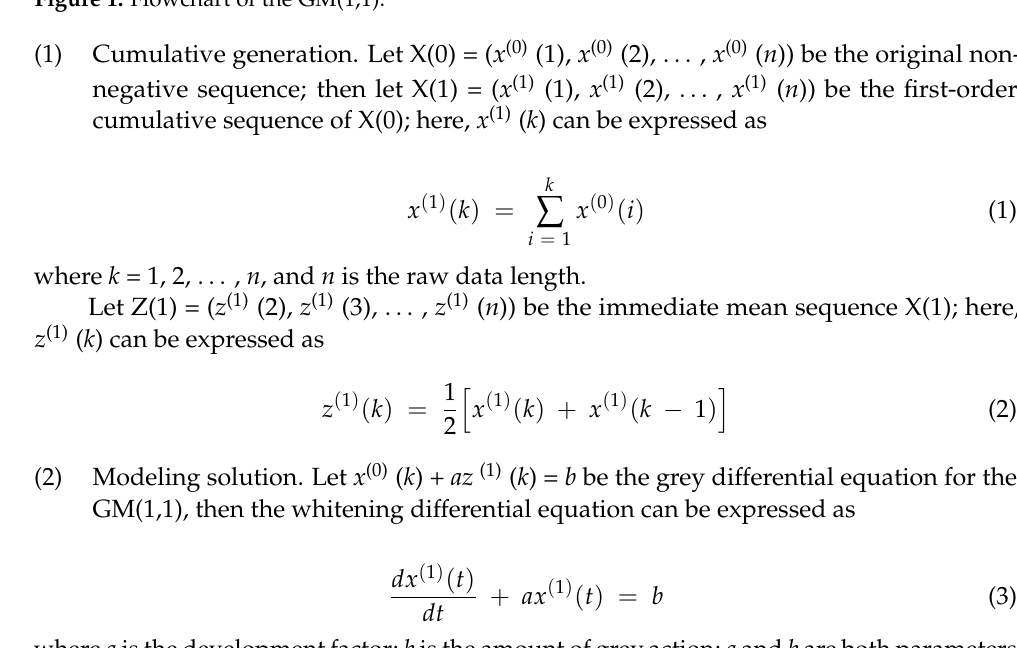
Figure 1. Flowchart of the